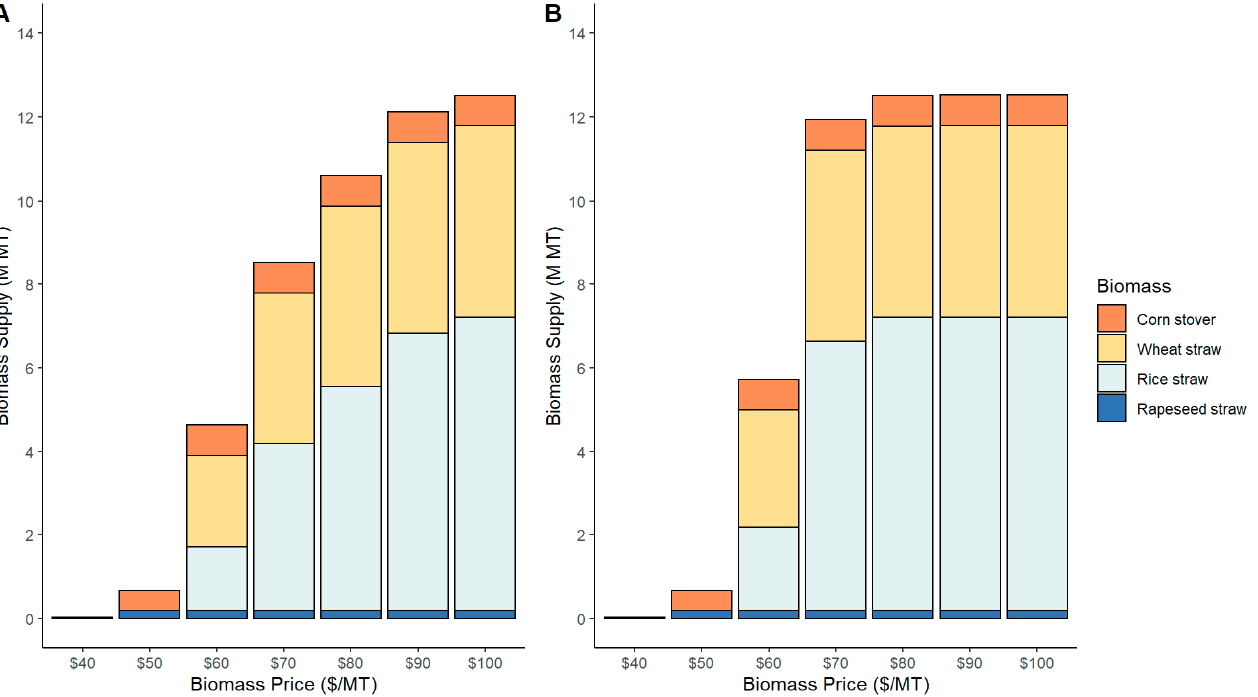
Figure 3. Supply and mix of feedstock under alternative scenarios of biomass prices and co-firing rates: ( A ) 10% co-firing rate; ( B ) 20% co-firing rate. rates: ( A ) 10% co-firing rate; ( B ) 20% co-firing